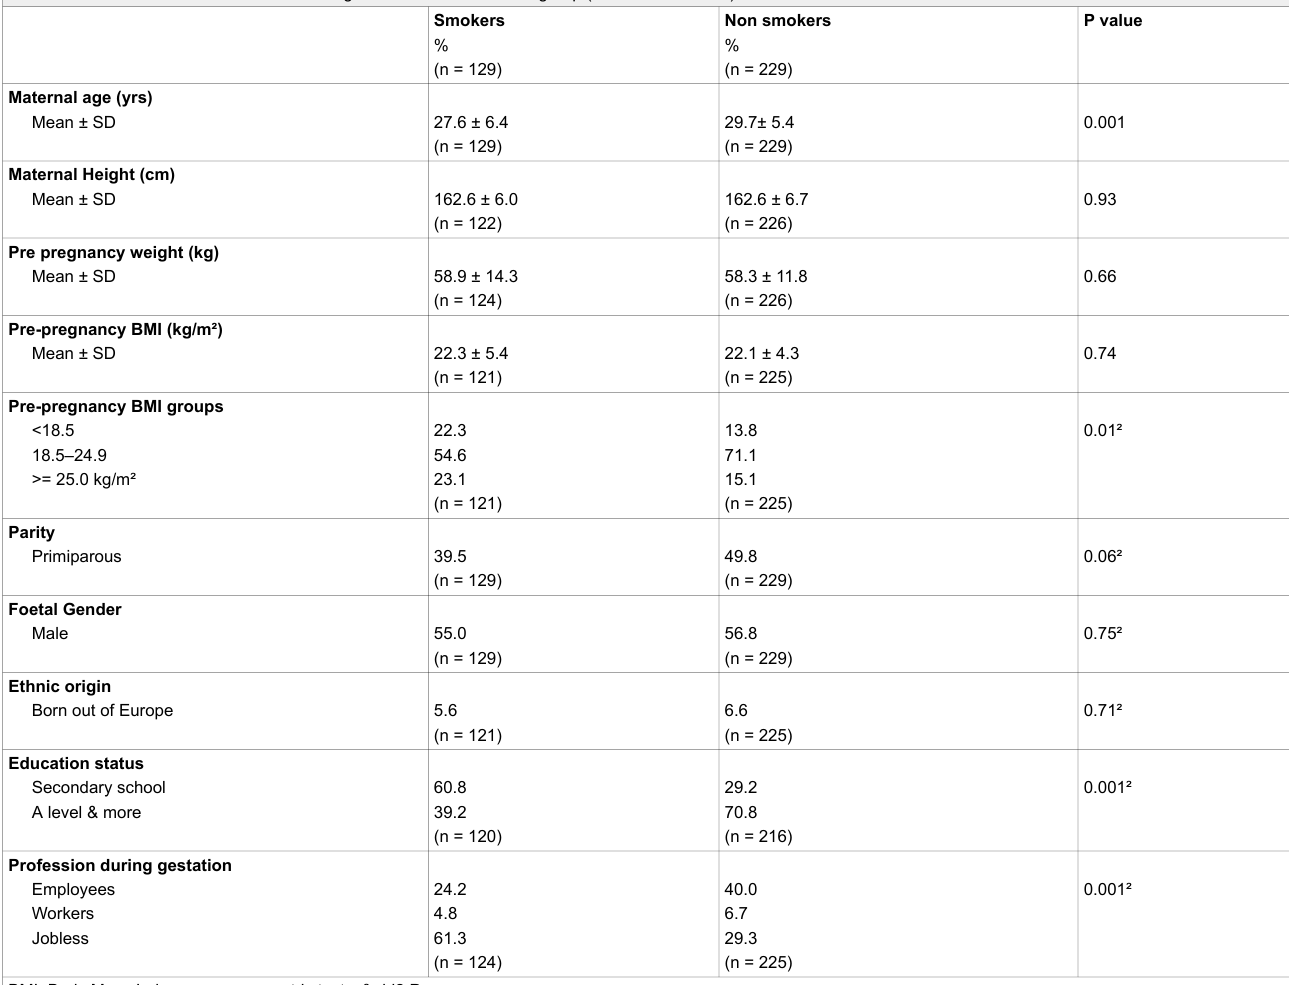
BMI: Body Mass Index; p non parametric test, p² chi2